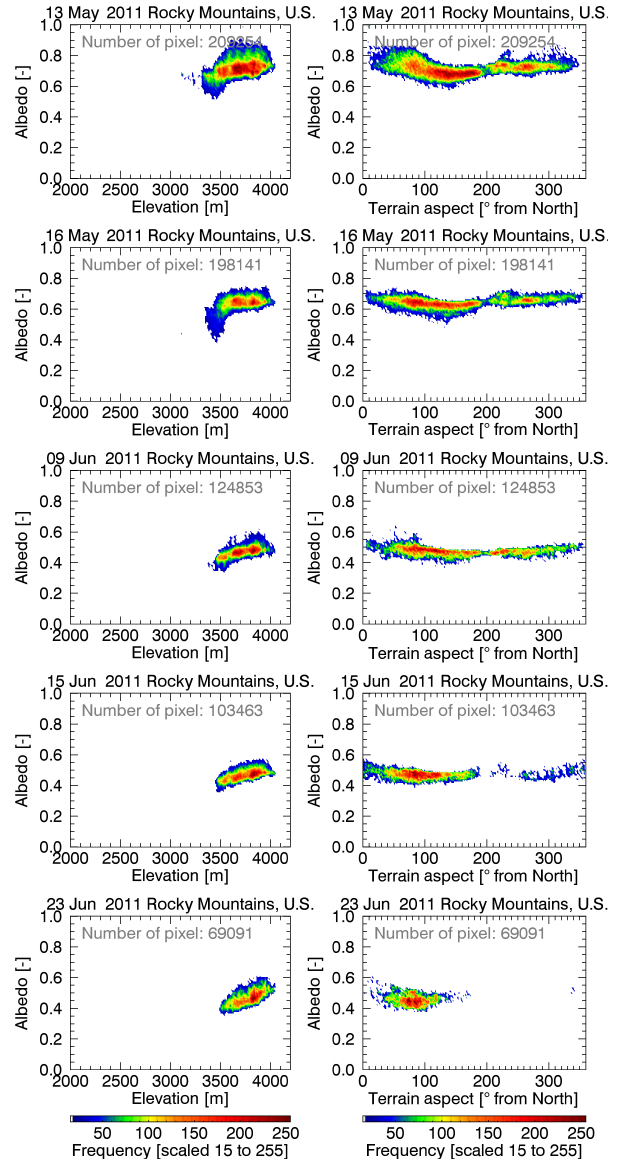
Figure 13. Same as Fig. 12 but for the Rocky Mountains in spring